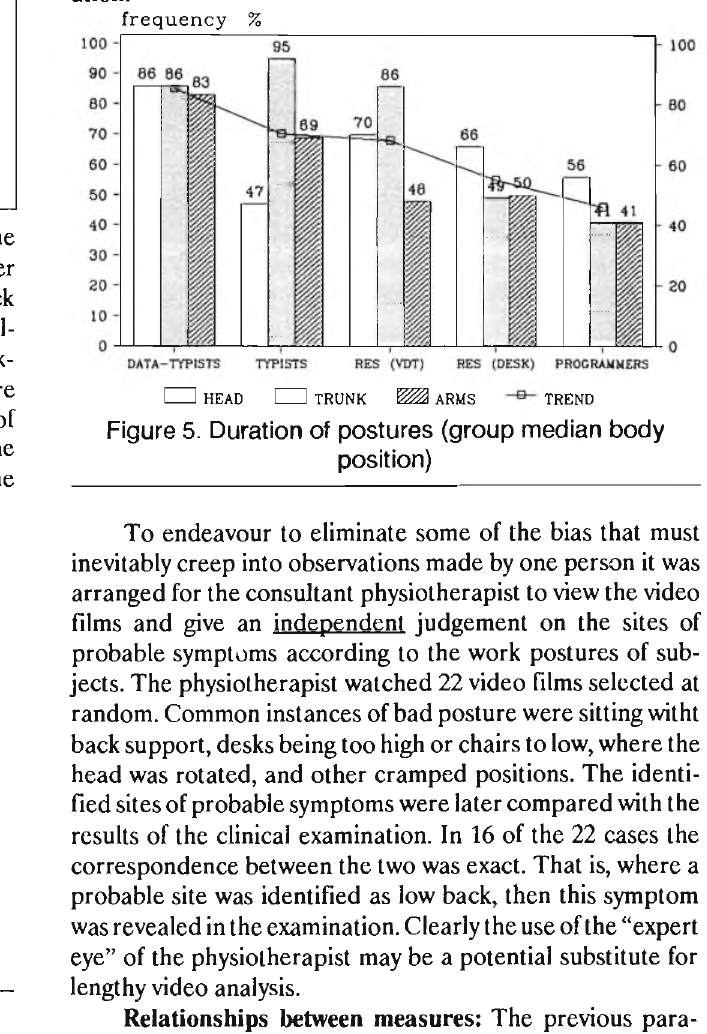
Figure 3. Classification of clinical symptoms. Table 1. Comparison of anthropometric and workstation dimensions